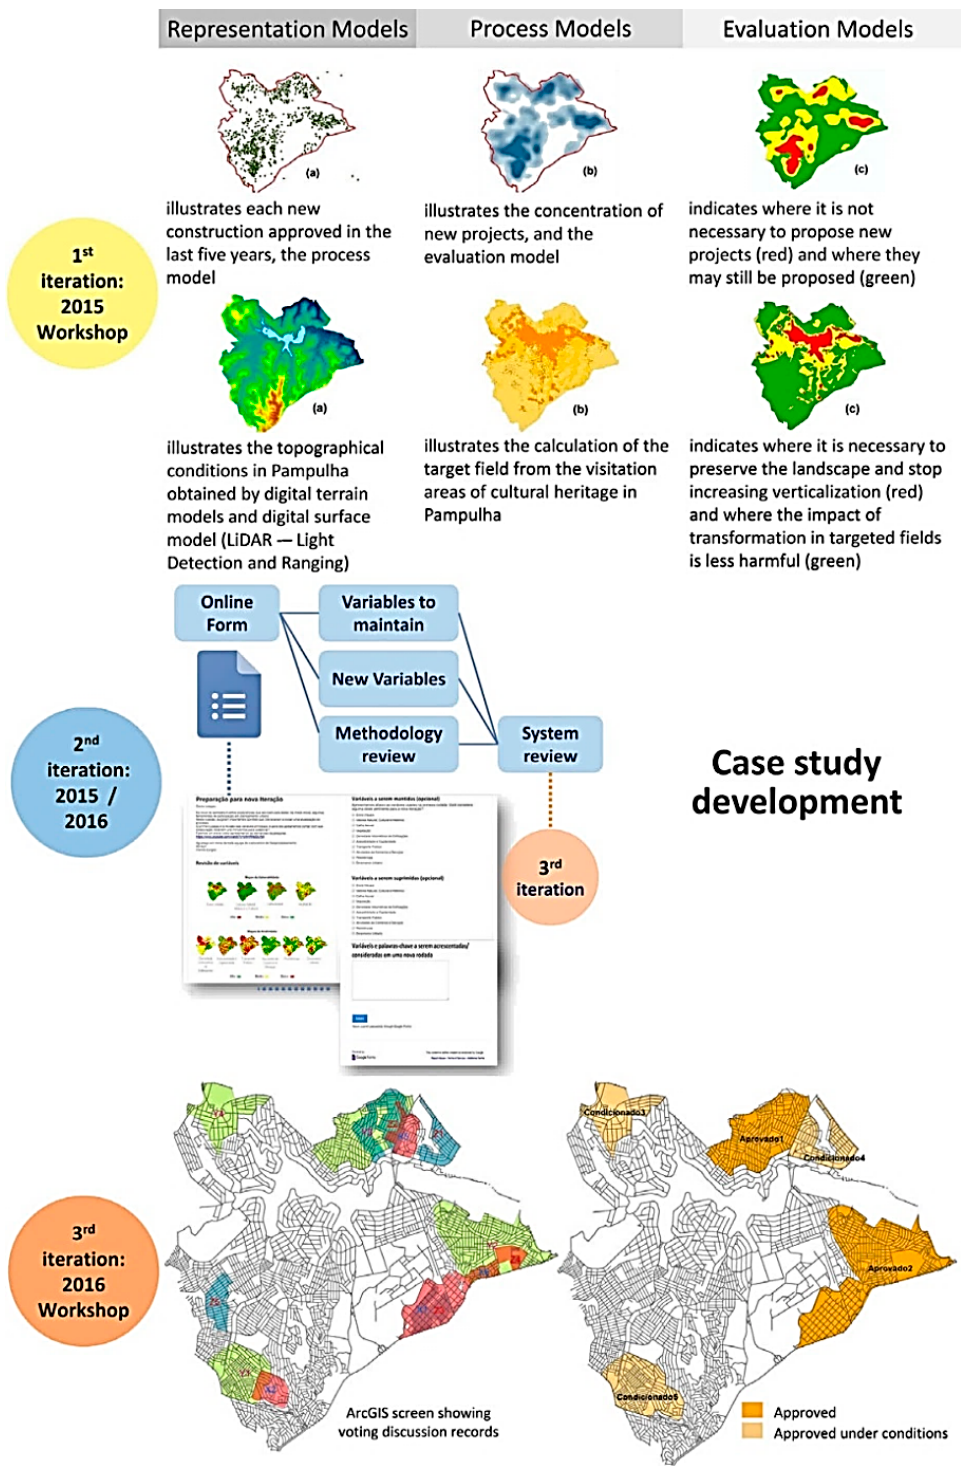
Figure 6. Pampulha case study Geodesign iterations. Each of the three iterations was performed using representation, process, and evaluation models. Source: Haklay et al. (2018) [96], (p. 142).